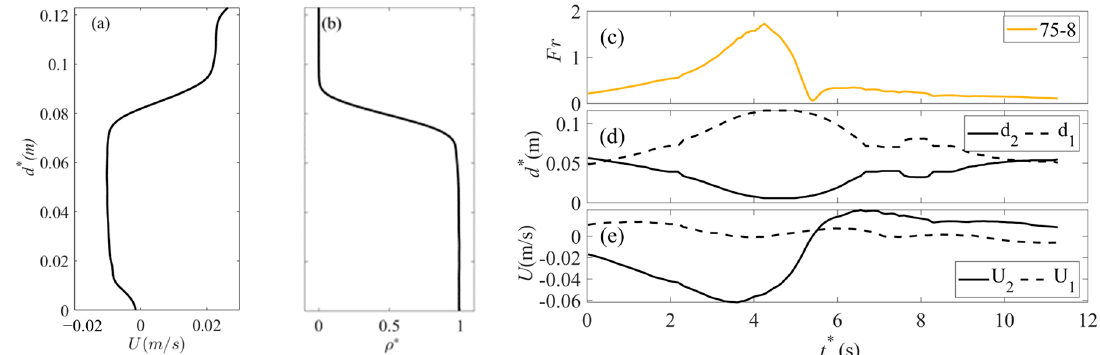
Figure 7. ( a , b ) Velocity and density profile and time series of ( c ) Froude number, ( d ) upper and lower depths and ( e ) velocity in upper and lower layers at the feature profile of Run 75-8.